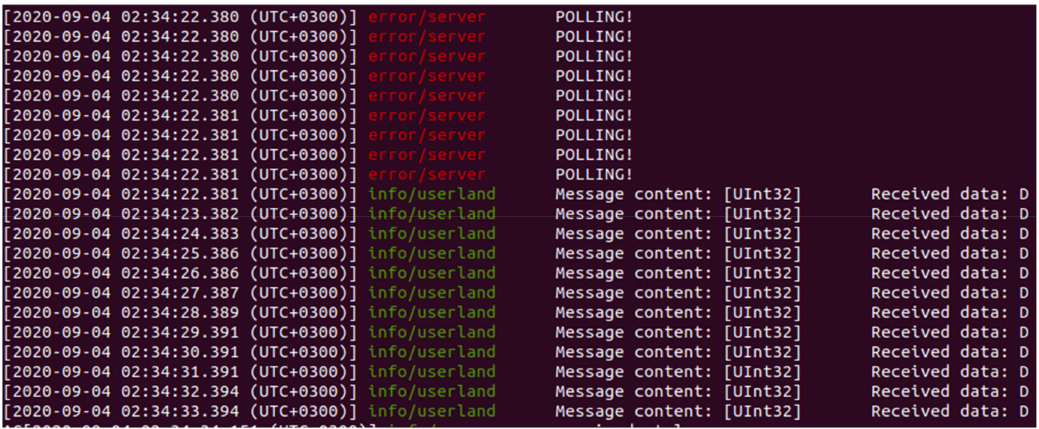
Figure 8. Terminal of Subscriber1 receiving the desired data at time intervals of 3 s.